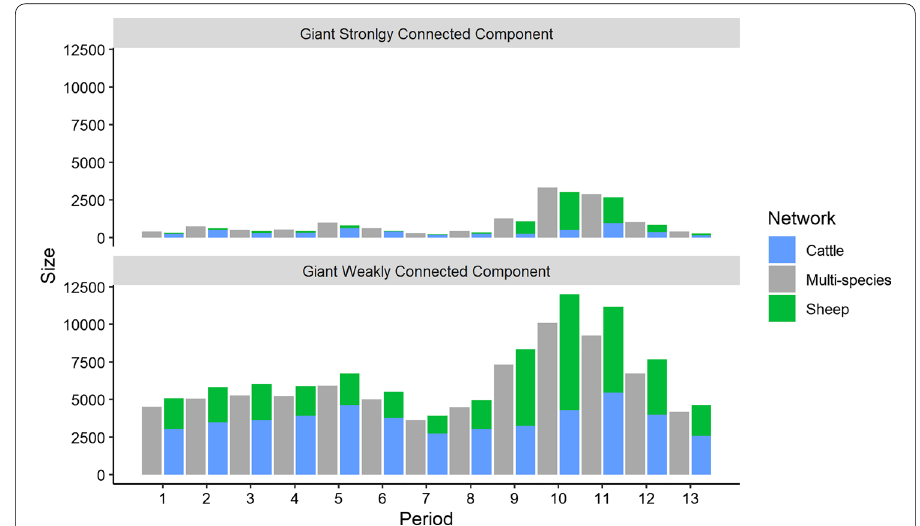
Fig. 5 Component sizes of the successive 4‑week static networks. This histogram shows the size of the GSCC, and GWCC in the multi‑species (in grey) and single‑species networks (cattle in blue, and sheep in green) along the year